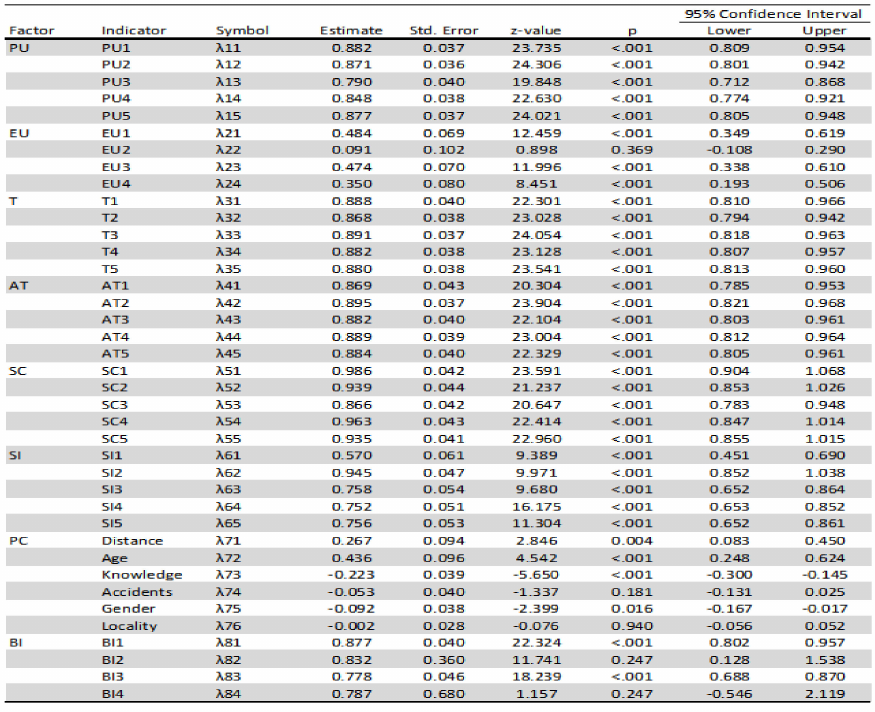
Figure 3. Factor loadings.